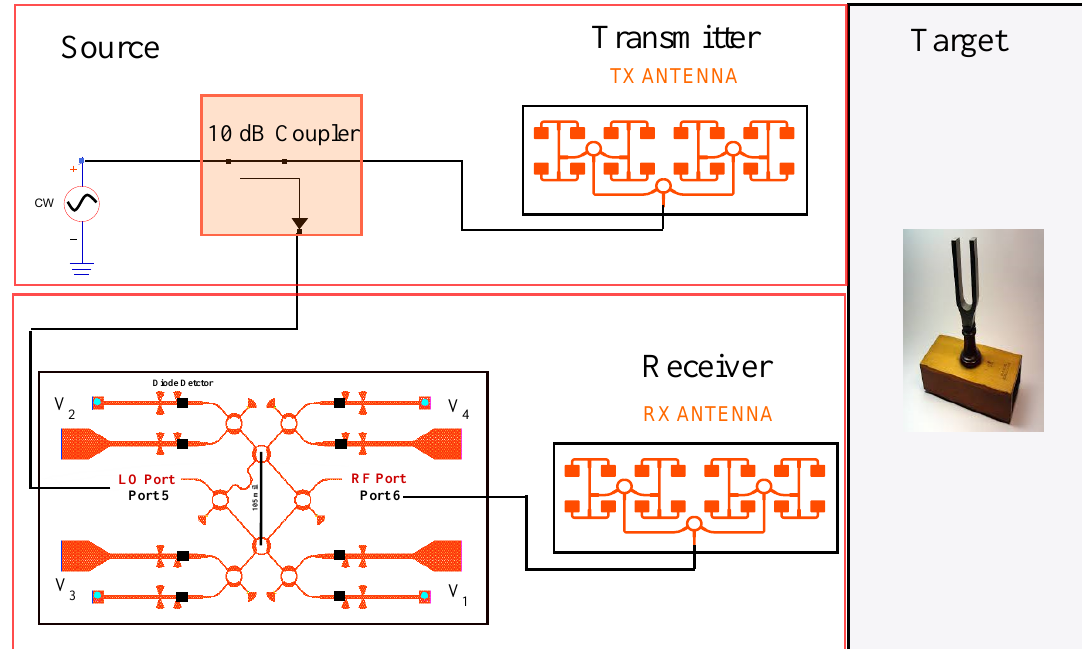
Figure 14. Block diagram of the 77-GHz